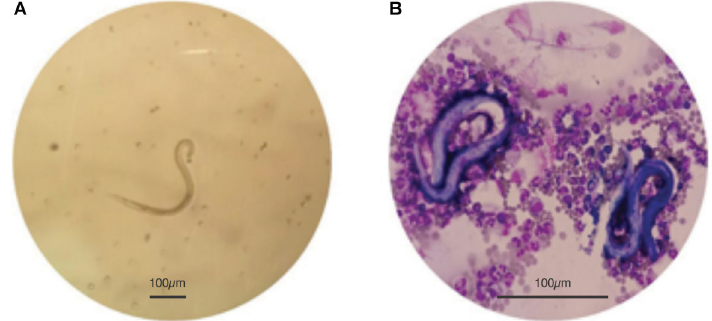
Figure 2. A , Presence of larvae in the fresh analysis of ascitic fl uid (200 (cid:1) ) and B , presence of Strongyloides larvae in a rich neutrophilic fl uid (Leishman staining, 600 (cid:1) ). Scale bars: 100 m fl uid (Figure 2). Parasitological examination of feces (methods of Faust and Lutz/Hoffman) con fi rmed eggs of Strongyloides stercoralis and in the modi fi ed Rugai method, the presence of S. stercoralis larvae. The duodenal biopsy showed intense in fl ammatory reaction and the presence of Strongyloides larvae.